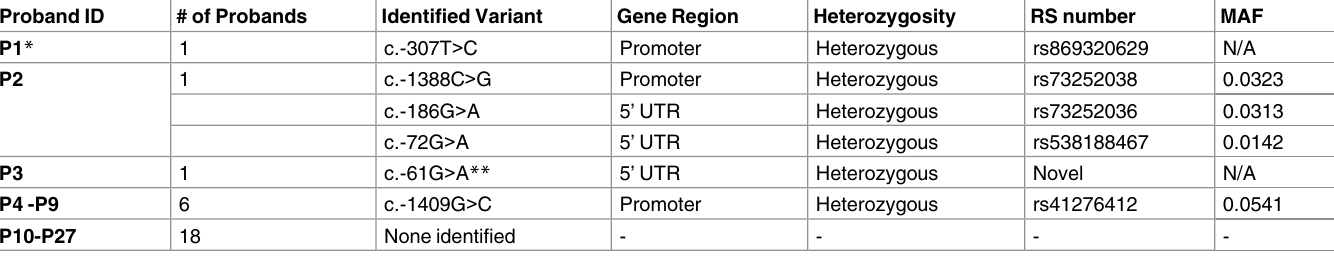
Table 1. OVOL2 promoter and 5’ UTR variants identified in 27 probands with PPCD. Proband ID